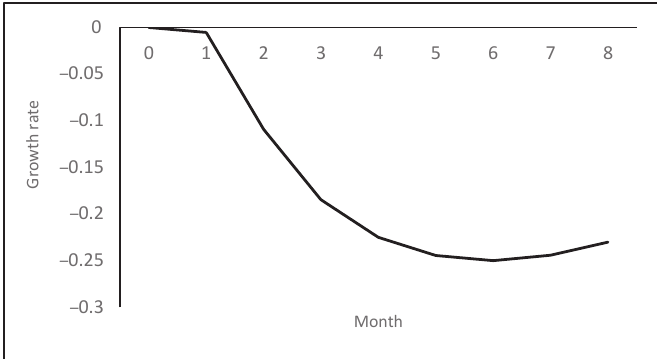
Figure 10. IRF TDC over